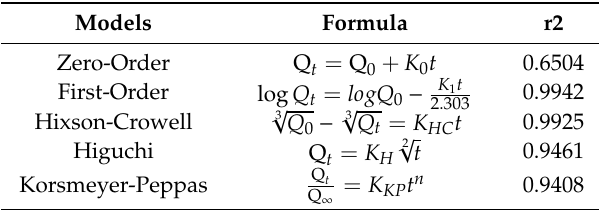
Table 1. Mathematical models used for fitting the experimental data of vesicles formed by PCL 16 -b-K 20 and different determination coefficients (r2).